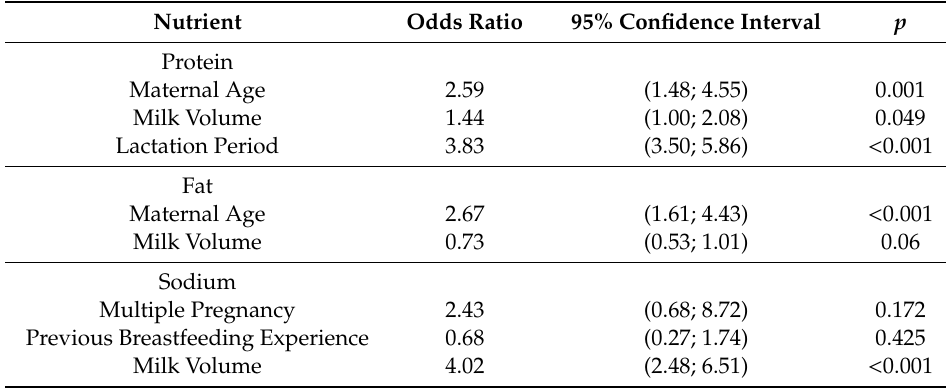
Table 4. Multivariate analysis by logistic ordinal